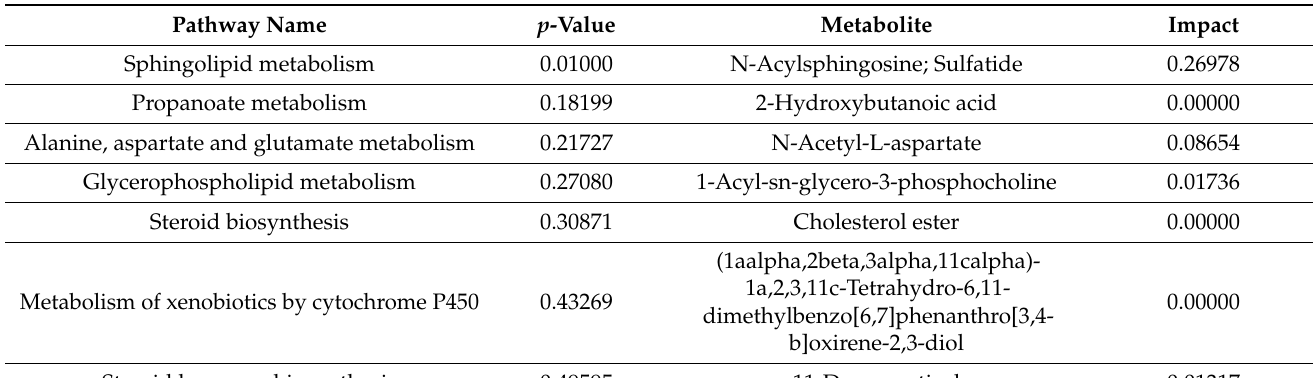
Table 4. The enriched KEGG pathway of differential metabolites of Cela/tMCAO in mouse